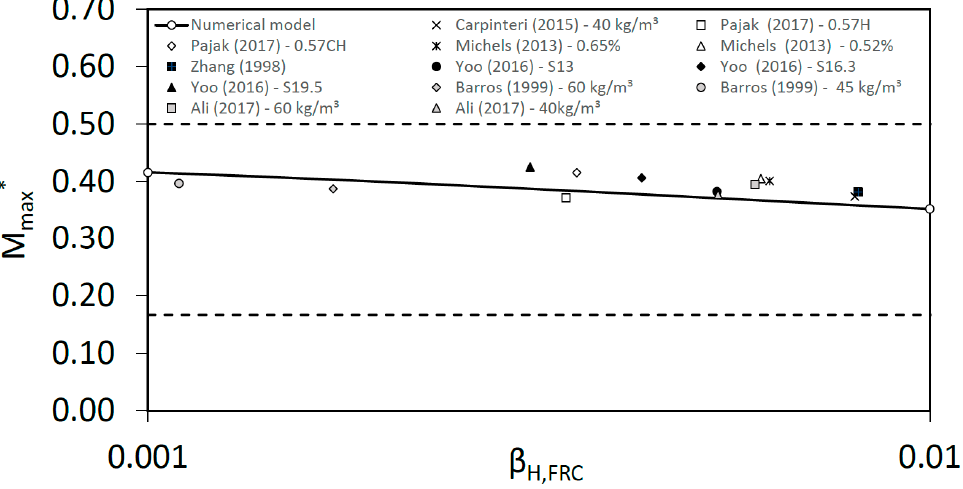
Figure 6. Non-dimensional maximum bending moment, M max * , versus brittleness number, β H,FRC .